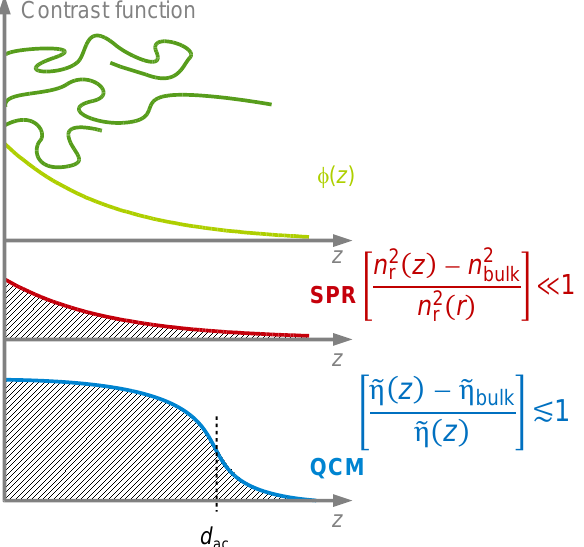
Figure 46. The contrast functions from Equation (58) and Equation (117) are similar, algebraically. The difference is in the numerical values. In optics, the refractive index varies by a few percent. The denominator is nearly constant. Because the change in n 2 r is about proportional to concentration, the integral of the contrast function is roughly proportional to the adsorbed amount. In the case of the QCM, the viscosity of an adsorbate layer easily exceeds the viscosity of the bulk by a factor of 10 or more. The contrast function saturates to unity and the integral of the contrast function is about proportional the acoustic thickness, d ac . d ac is the distance, at which the sample’s viscosity has decreased to about twice the viscosity of the bulk.